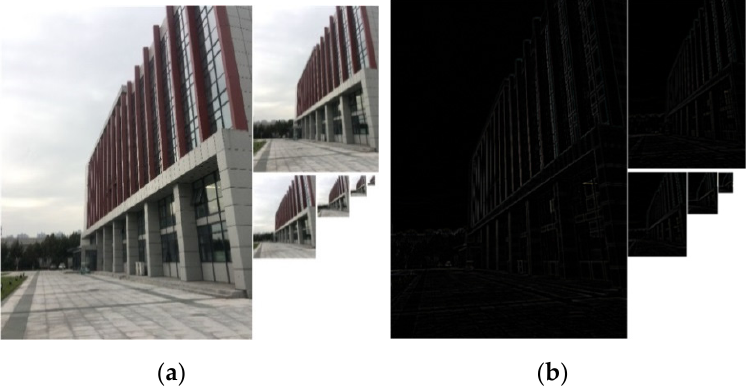
Figure 6. The Gaussian and Laplacian pyramid results of the raw image. ( a ) The result of the Gaussian pyramid; ( b ) The result of the Laplacian pyramid.